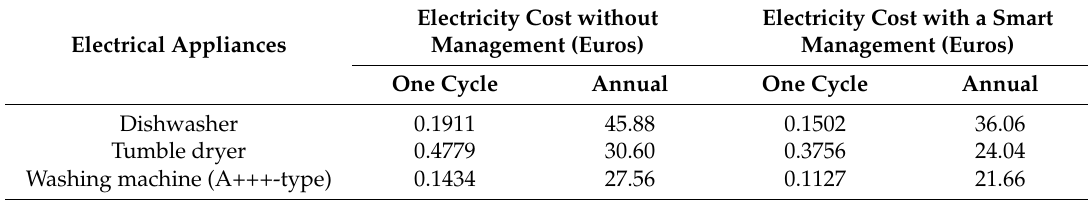
Table 5. Electricity cost savings: benefits of a smart management of the electricity consumption. Electricity Cost without Electricity Cost with a Smart Electrical Appliances Management (Euros) Management (Euros) One Cycle Annual One Cycle